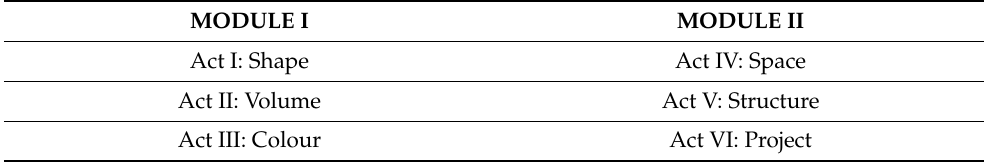
Table 2. 1st year of the Degree in Industrial Design and Product